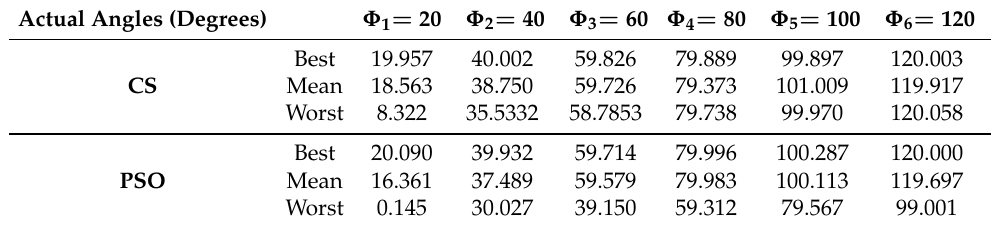
Table 1. Calculation of accuracy for six targets at 0 dB SNR.